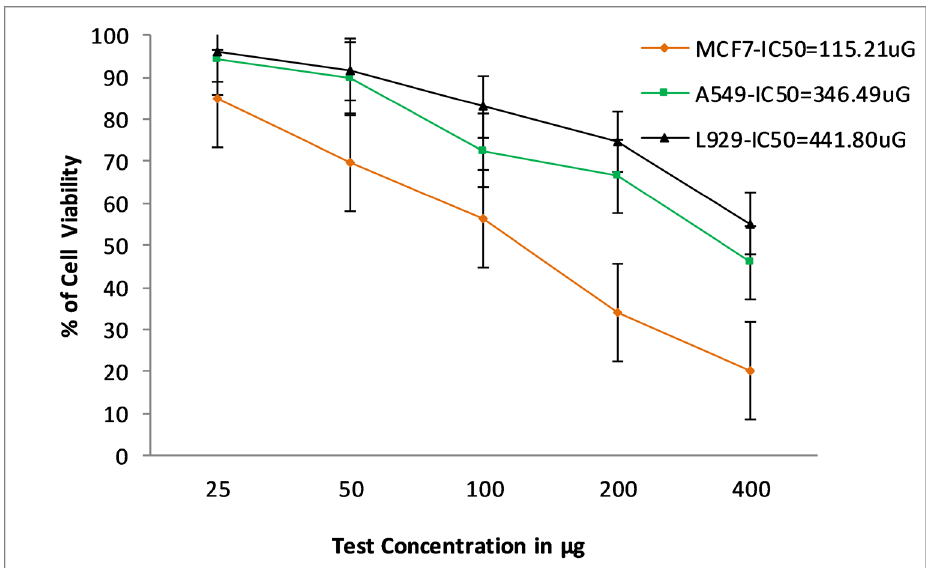
FIGURE 2 - Test sample Fucoidan extracted from Turbinaria conoides was treated with MCF7 (Breast Cancer Cell Line), A549 (Lung cancer cell line, and L929 (Normal fibroblast cell line) to check the viability of the cancer cell lines and the normal cell line. The concentration of the test sample Fucoidan was taken in varying concentrations like 25, 50, 100, 200, 400µg/ml against its percentage of viability. The graph represents that, the percentage of cell viability decreases as the concentration of the test sample Fucoidan increases. MCF7 cell line showed a significant decrease in the cell viability compared to A549 cell lines with the IC 50 value 115.21µg for MCF7, 346.49µg for A549 cell lines and normal mouse fibroblast cell line was viable to the test sample with the IC 50 value